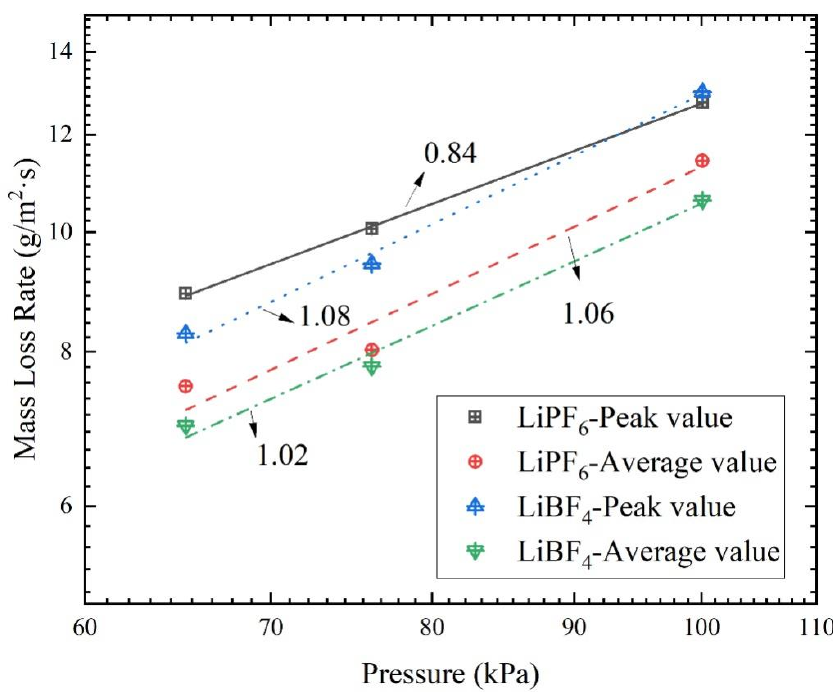
Figure 9. Peak and average values of MLR in stable combustion stage with the change of pressure: peak value for sample with LiPF 6 (black), average value for sample with LiPF 6 (red), peak value for sample with LiBF 4 (blue), average value for sample with LiBF 4 (green).